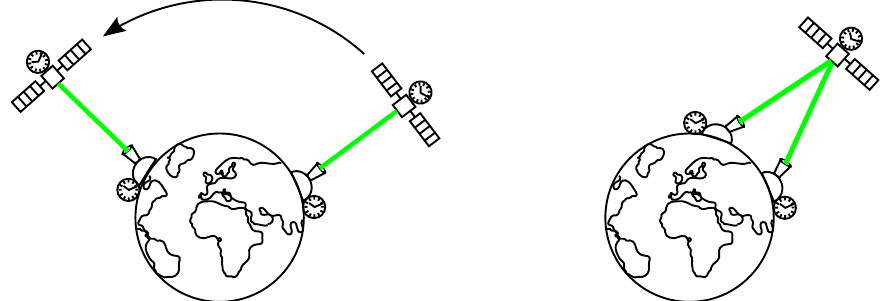
Figure 15. Diagram of optical time transfer via satellite comprising both common view mode ( right ) and non-common view mode ( left